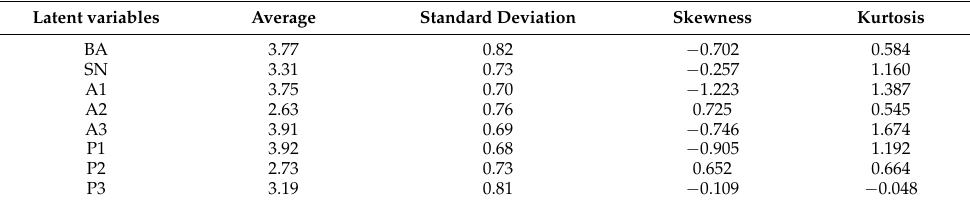
Table 4. Statistical characteristics of farmers’ attitudes toward waste classification, awareness, percep- tion, and other indicators.